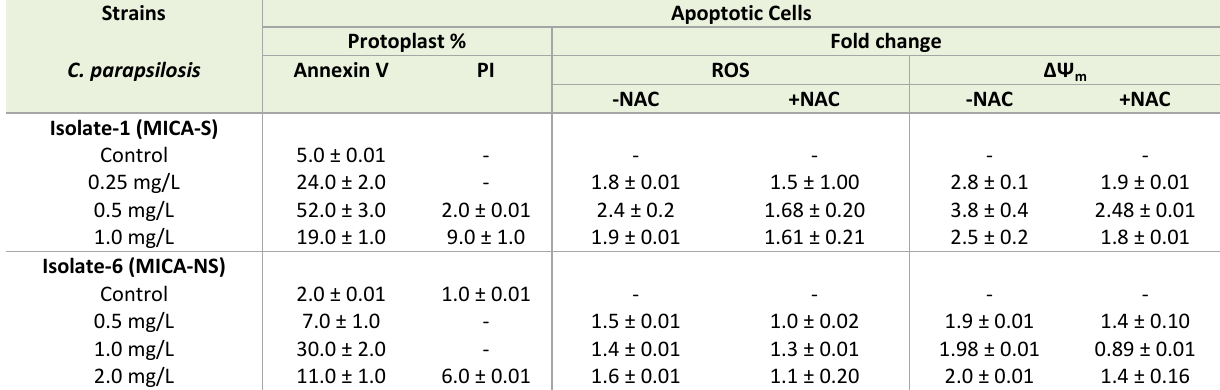
TABLE 1. Apoptotic cells and fold changes in fluorescence intensity of MICA-S and MICA-NS C. parapsilosis strains treated with micafungin.